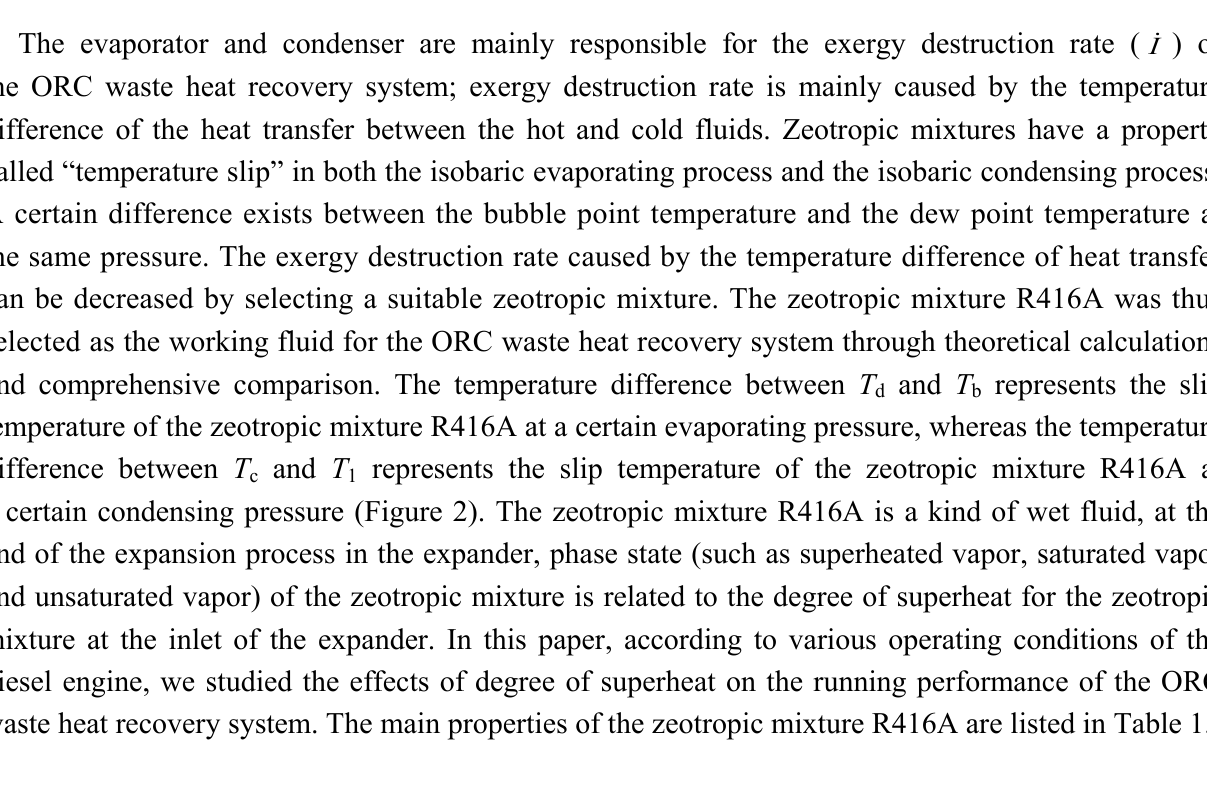
Table 1. Main properties of the zeotropic mixture R416A. ODP: ozone depletion potential; and GWP: global warming